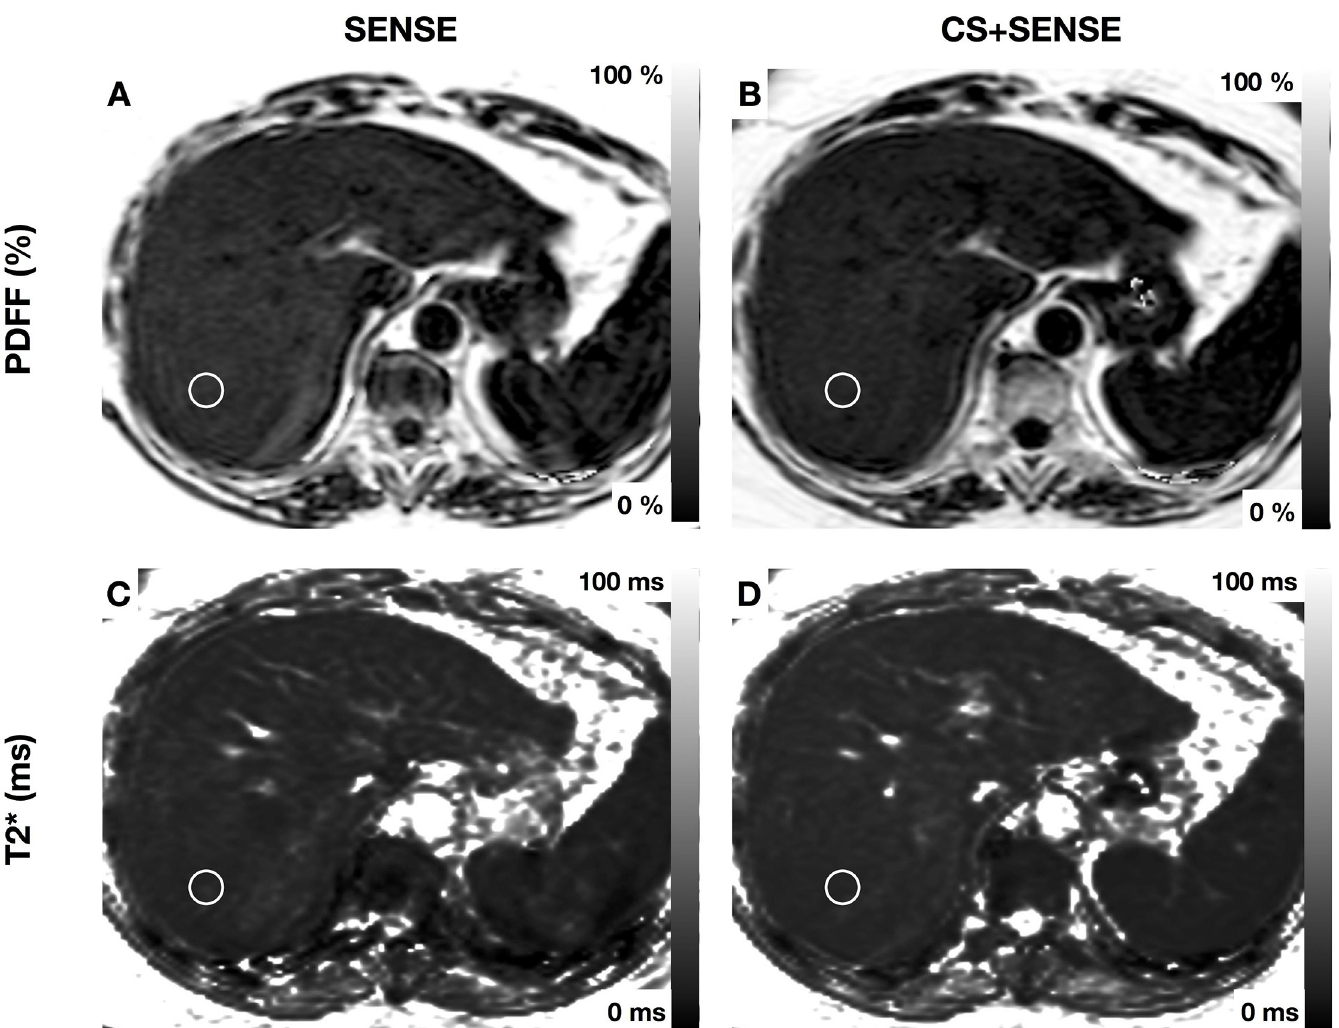
Fig 1. MRI was performed for evaluation of cystic pancreatic lesion. Exemplary region of interest is drawn in segment VII (1.5cm). PDFF: acquisition with SENSE 11.1 ± 2.4% (A); acquisition with CS+SENSE 10.8 ± 1.5% (B); T2 � : acquisition with SENSE 9.35 ± 0.6ms (C); acquisition with CS+SENSE 9.28 ± 0.5ms (D).